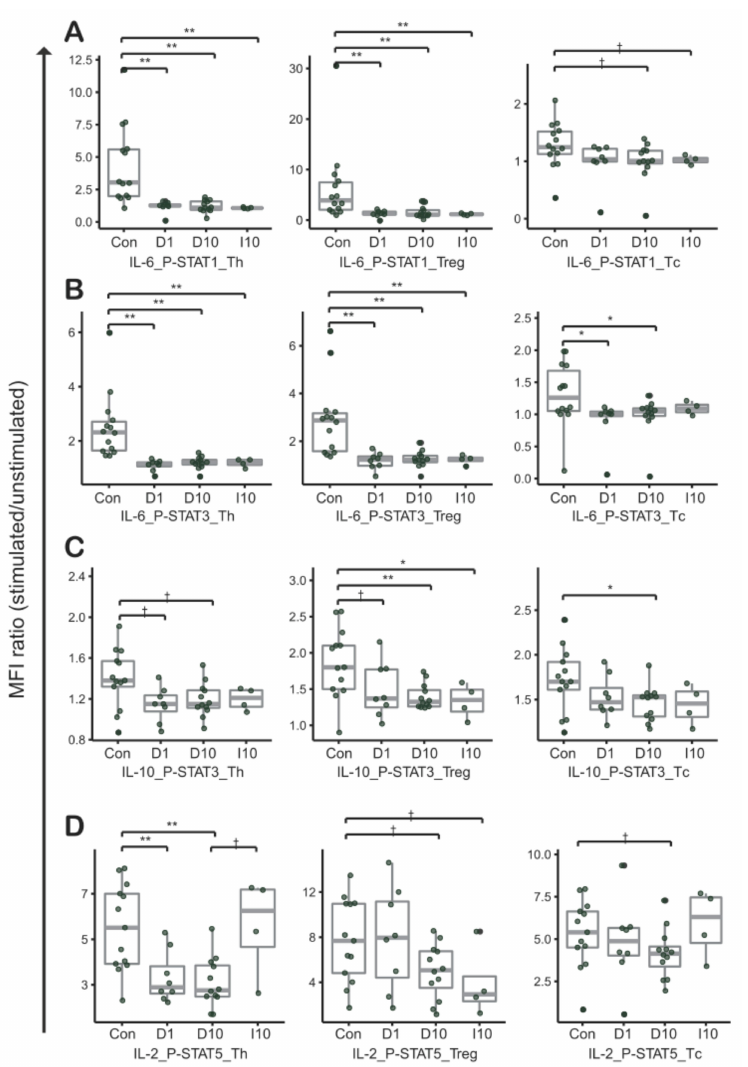
Figure 3. Cytokine induced phosphorylated STAT signatures between peripheral blood mononuclear cells (PBMCs) and PBMCs co-cultured with the HCT116 cancer cell line. Phospho-flow cytometry was performed in combination for ( A ) IL-6 and STAT1, ( B ) IL-6 and STAT3, ( C ) IL-10 and STAT10, and ( D ) IL-2 and STAT5. The overall pattern between control cells and PBMCs co-cultured with HCT116 cells is similar to the pattern between control cells and TILs in Figure 2. “Con” represents control (T cells from PBMCs of healthy donors, N = 14). “D1” represents T cells from PBMCs co-cultured in direct contact with HCT116 cells (1:1, N = 8). “D10” represents T cells from PBMCs co-cultured in direct contact with HCT116 cells (1:10, N = 12). “I10” represents T cells from PBMCs co-cultured in indirect contact with HCT116 cells (1:10, N = 4).; † , p -values < 0.1; *, p -values < 0.05; **, p -values < 0.01 in Mann-Whitney-Wilcoxon test; middle line in box plot represents median and upper and lower sides are 1st and 3rd quantiles, respectively. Whiskers above and below the box plot represents values exceeding the 1st–3rd quantile